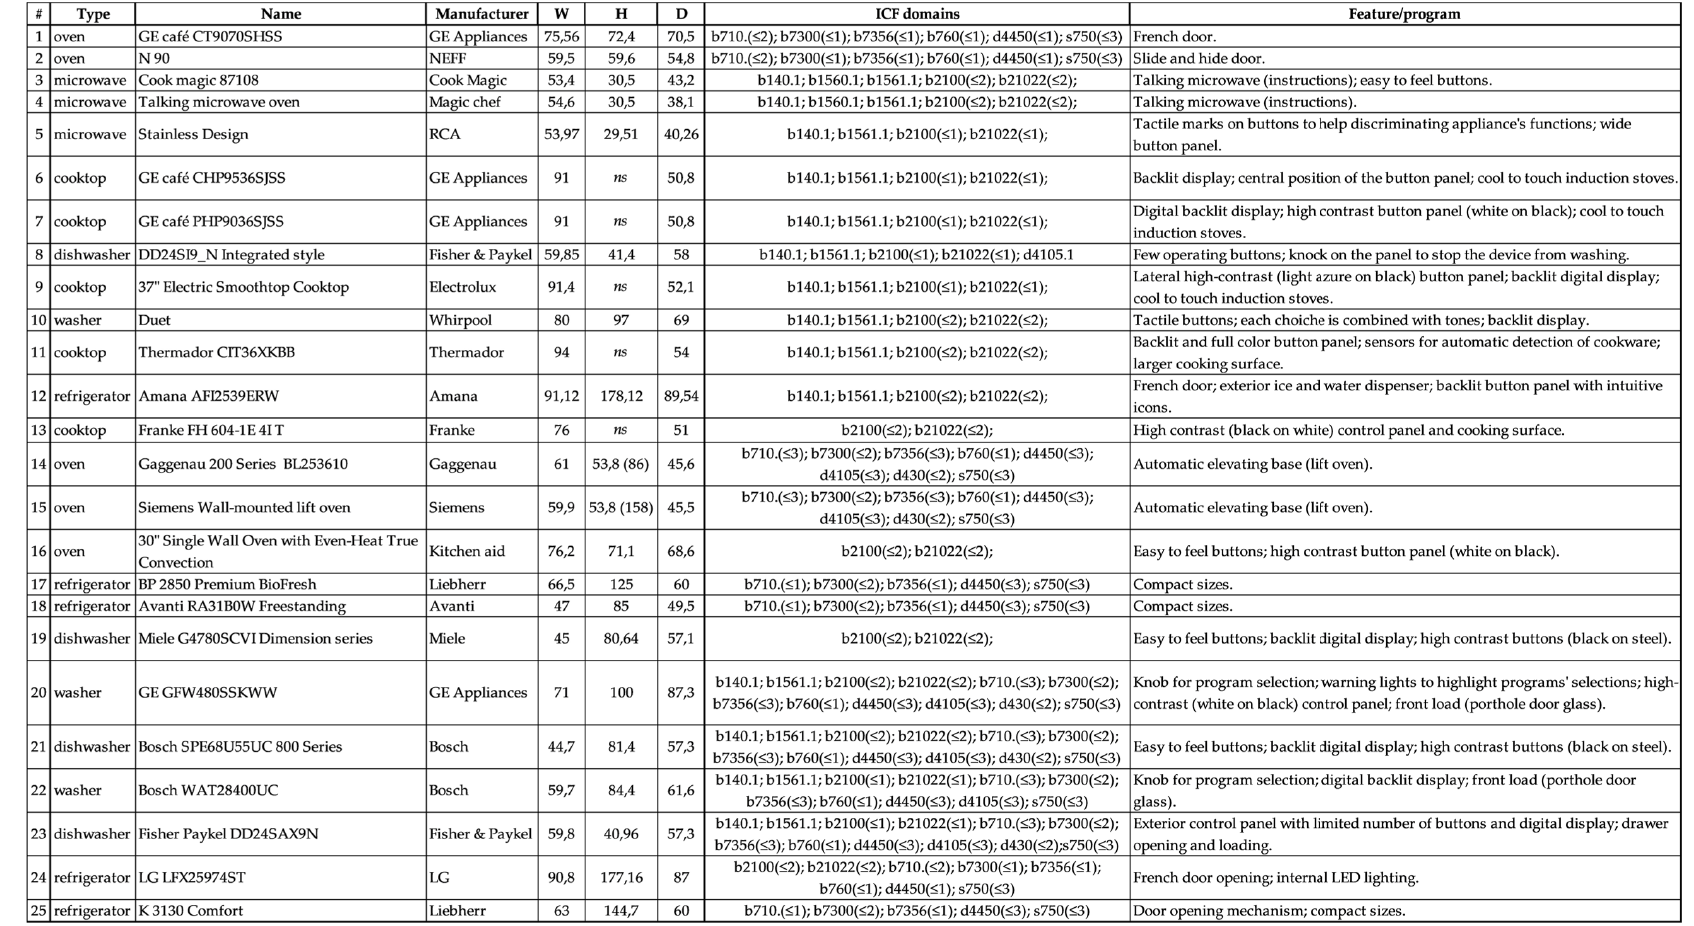
Figure A1. A recapitulatory schema of the work conducted by the expert group on a set of 25